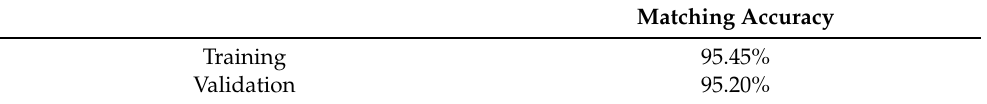
Figure 4. Performance of whole-vehicle matching neural network during training. Table 3. Vehicle matching network performance.